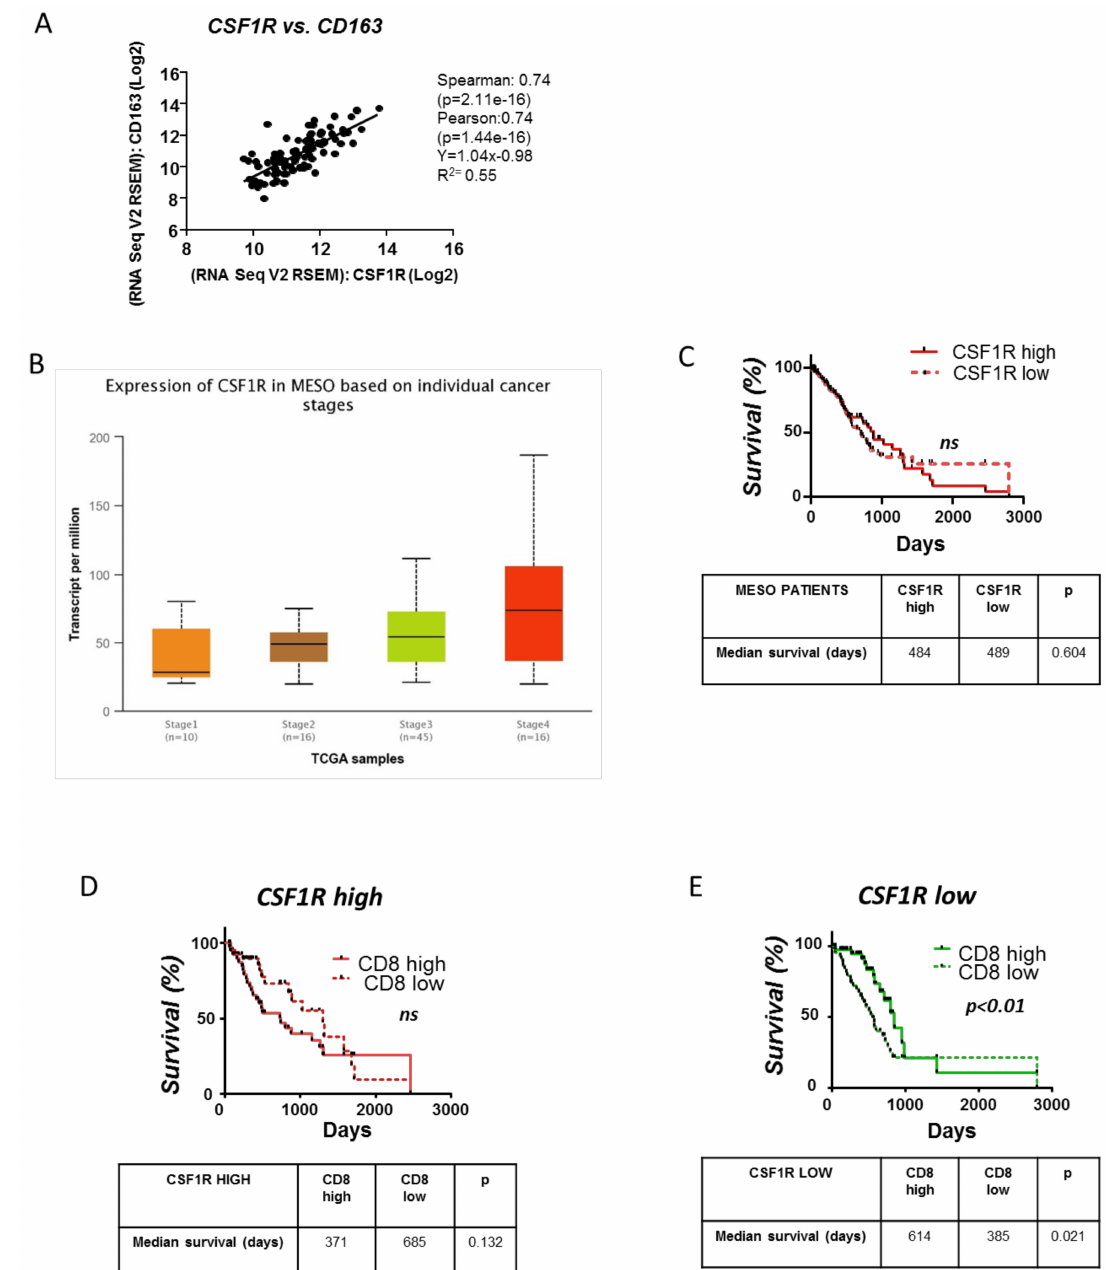
Figure 6. Clinical significance of the CSFR1 expression and the interplay between CSFR1 expressing macrophages and CD8+ cells in mesotheliomas. RSEM data of RNAseq analysis of 88 mesothelioma tumor samples were retrieved by